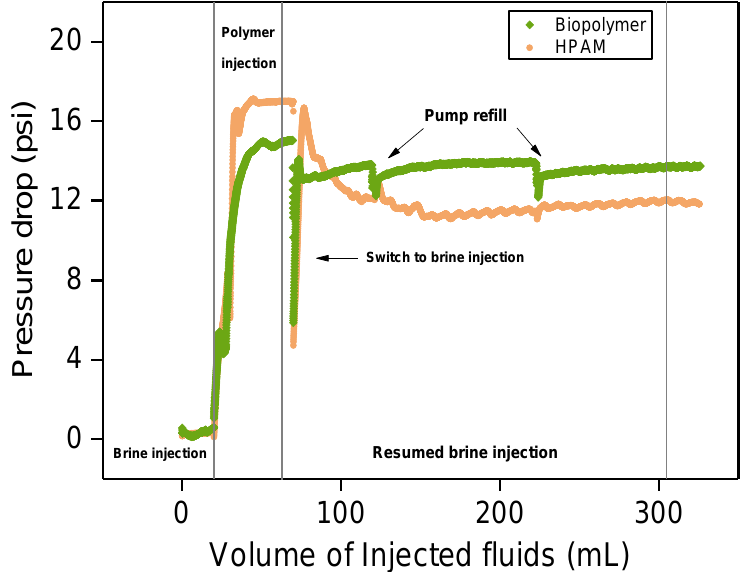
Figure 12. Pressure drop during brine and polymer solution injection.